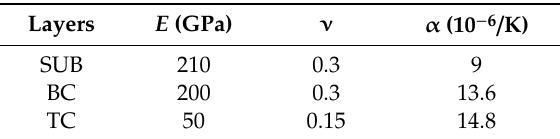
Table 1. Material properties (Young’s modulus E , Poisson ratio ν , and Thermal expansion coe ffi cient α ) of SUB, BC, and TC